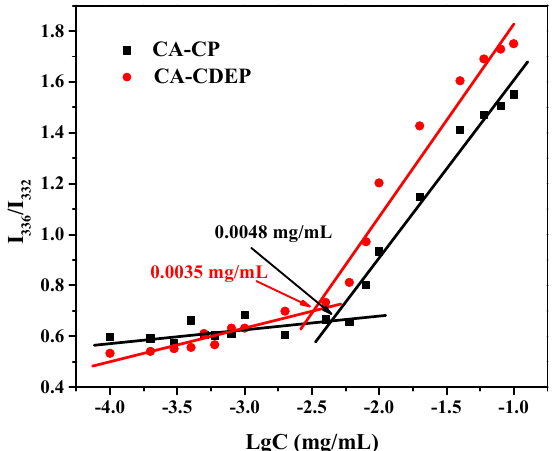
Figure 3. Intensity ratio (I 336 /I 332 ) in the fluorescence spectra of pyrene as a function of polymeric concentrations in aqueous solution.